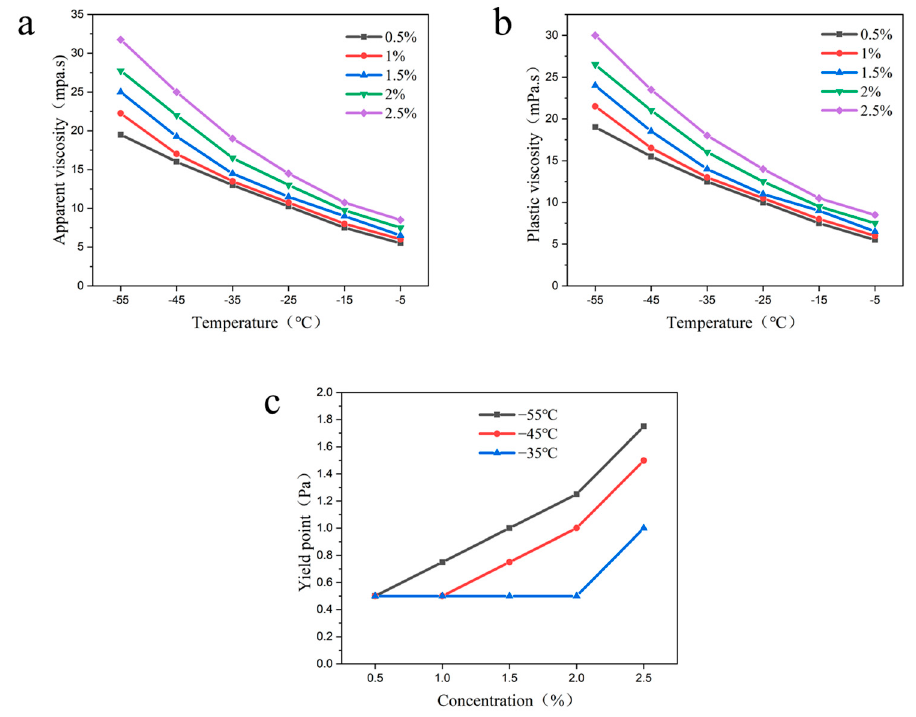
Figure 6. Effects of dimeric acid at different concentrations on the rheological properties of drilling fluid; ( a ) apparent viscosity; ( b ) plastic viscosity; ( c ) yield point.